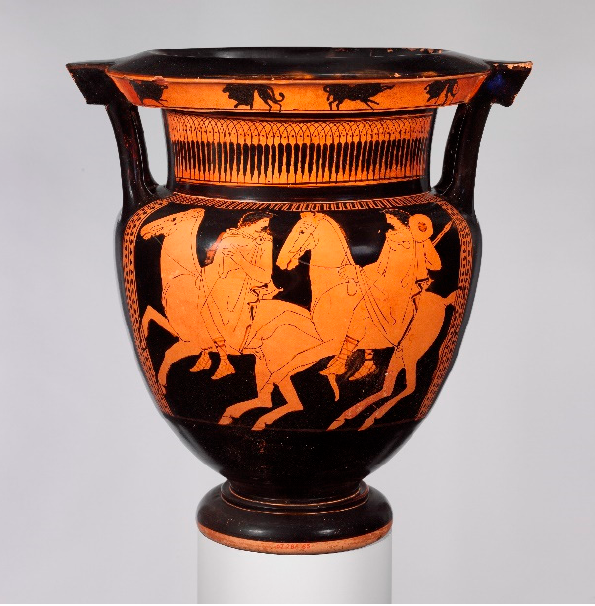
Figure 10. Column-Krater attributed to the Marlay Painter. Ca. 430 BCE. Metro-politan Museum of Art. Rogers Fund. Inv. no. 07.286.65.